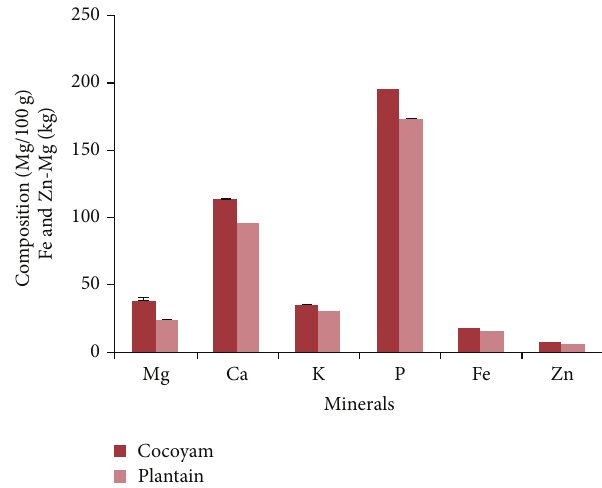
Figure 1: Mineral composition of cocoyam and unripe plantain incorporated feeds.